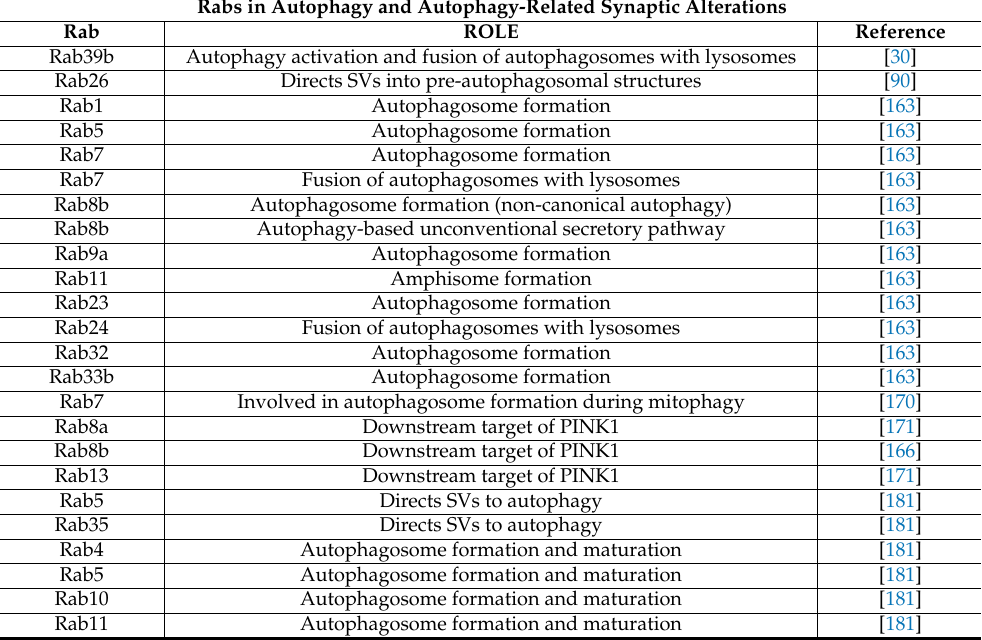
Table 3. Involvement of Rabs in autophagy and autophagy-related synaptic